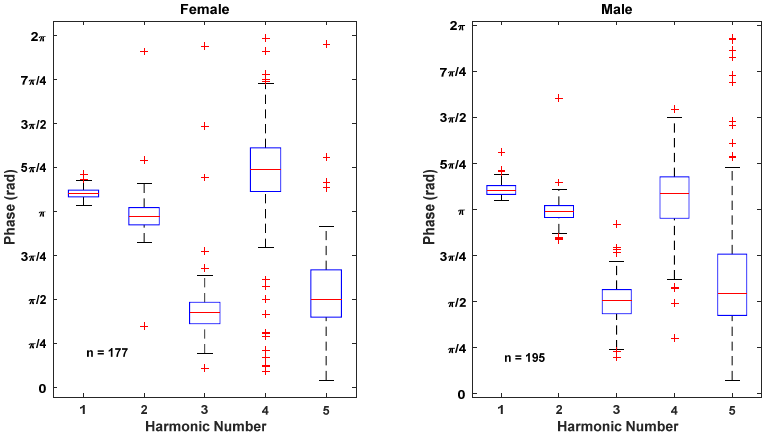
Figure 8. Distributions of normalized harmonic amplitudes of first four overtones for all female and male trials.